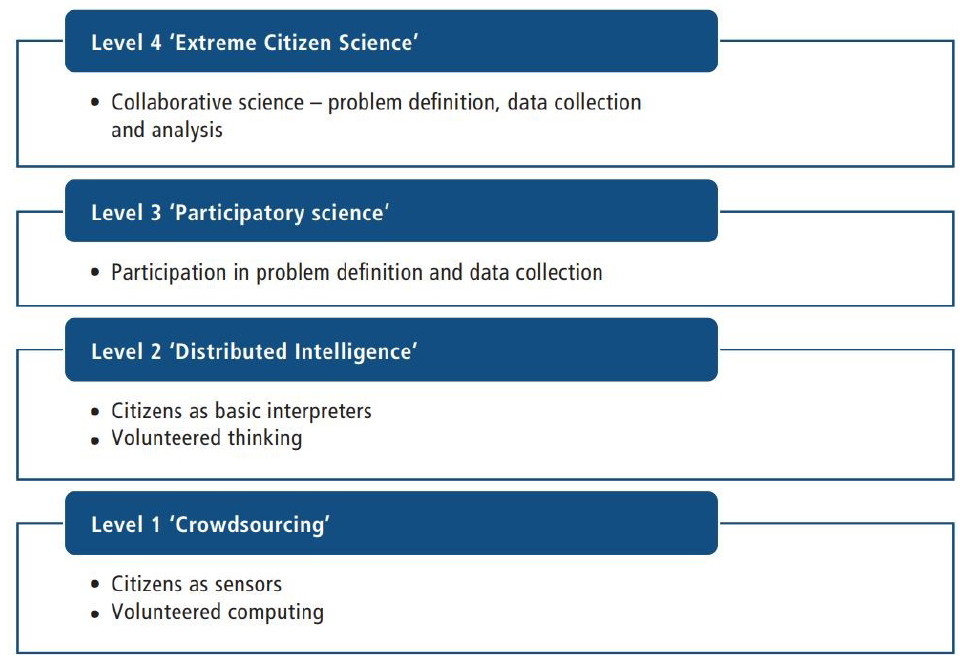
Figure 3 Levels of participation in citizen science (Haklay,